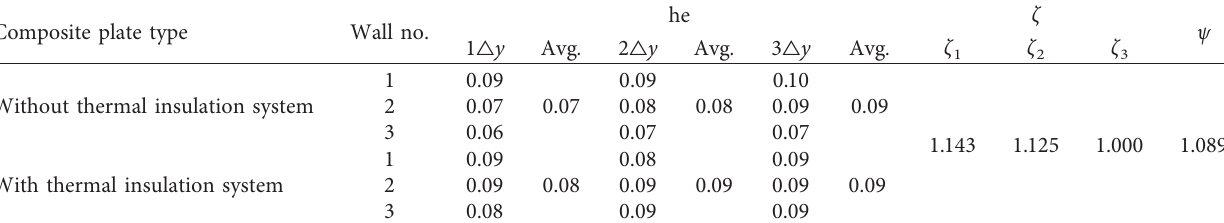
Table 4: Damping data sheet.